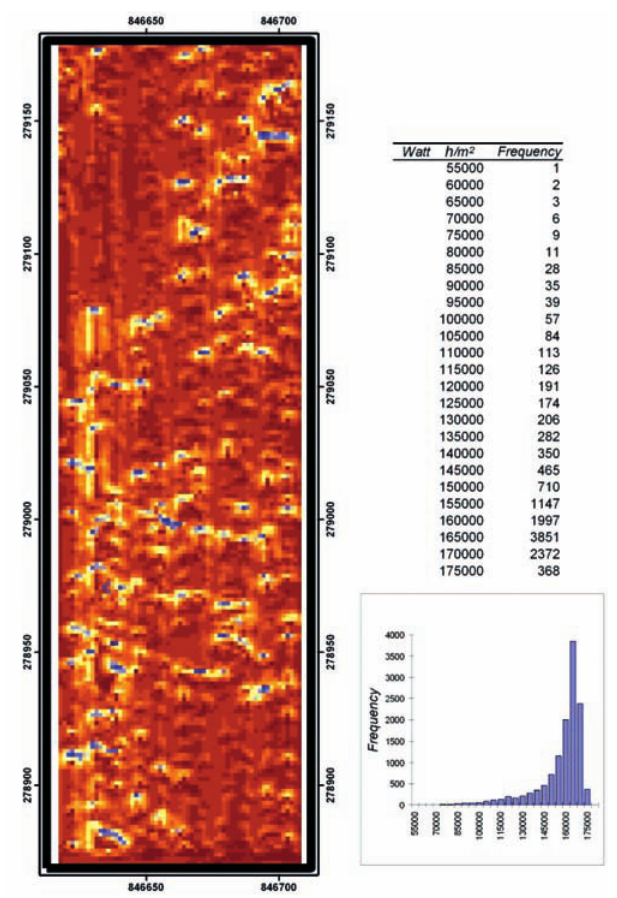
Figure 9. Direct radiation values in June